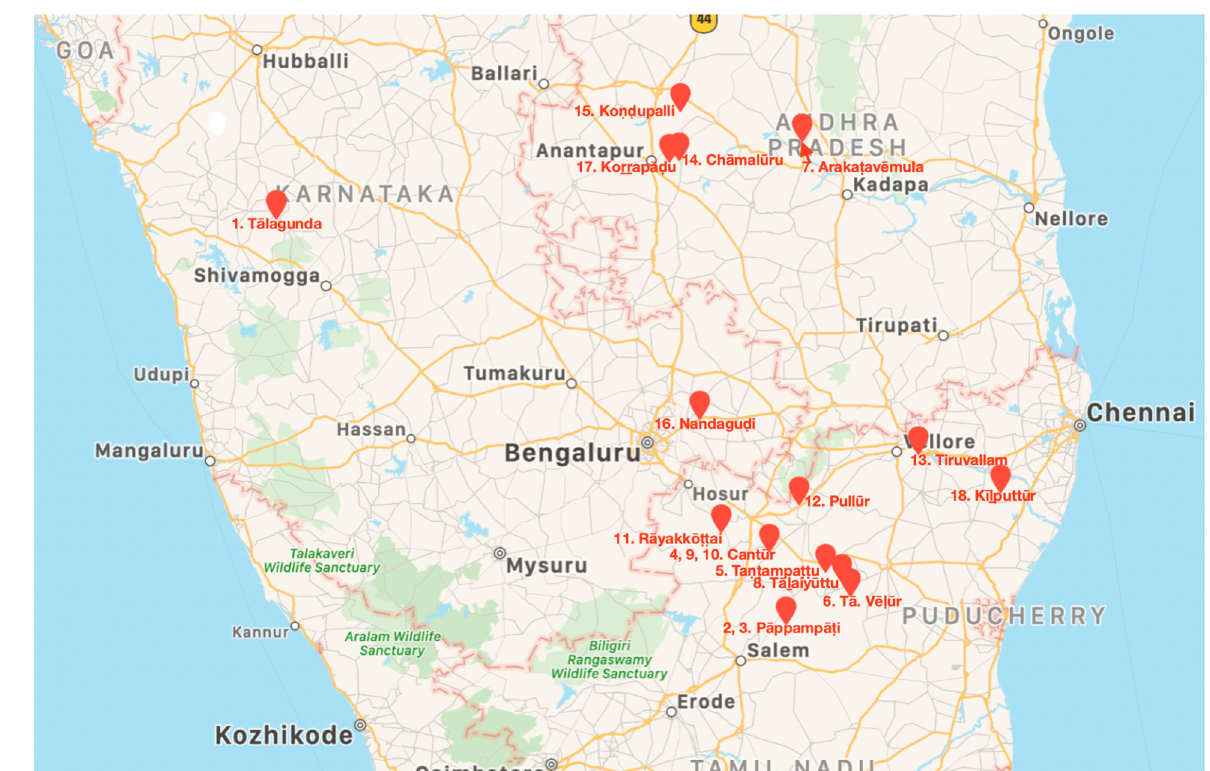
Br.hadb¯an. a. Later, under pressure from the Western C¯al.ukyas, the B¯an. as moved south and returned to the region straddling the northern border of the Tamil country as well as the southern Telugu and Kannada regions.